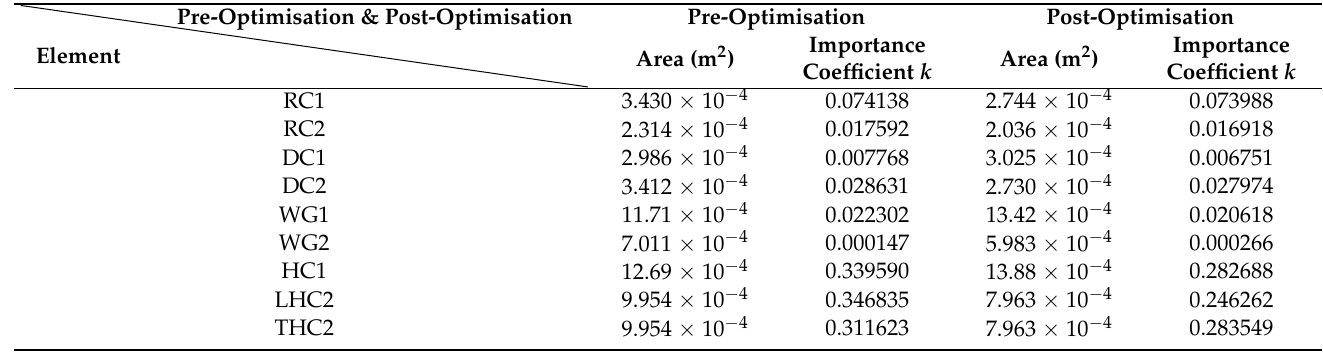
Figure 4. Iterative process of element section optimisation. Table 7. Cross-sectional areas and importance coefficients of different elements before and after comprehensive optimisation.